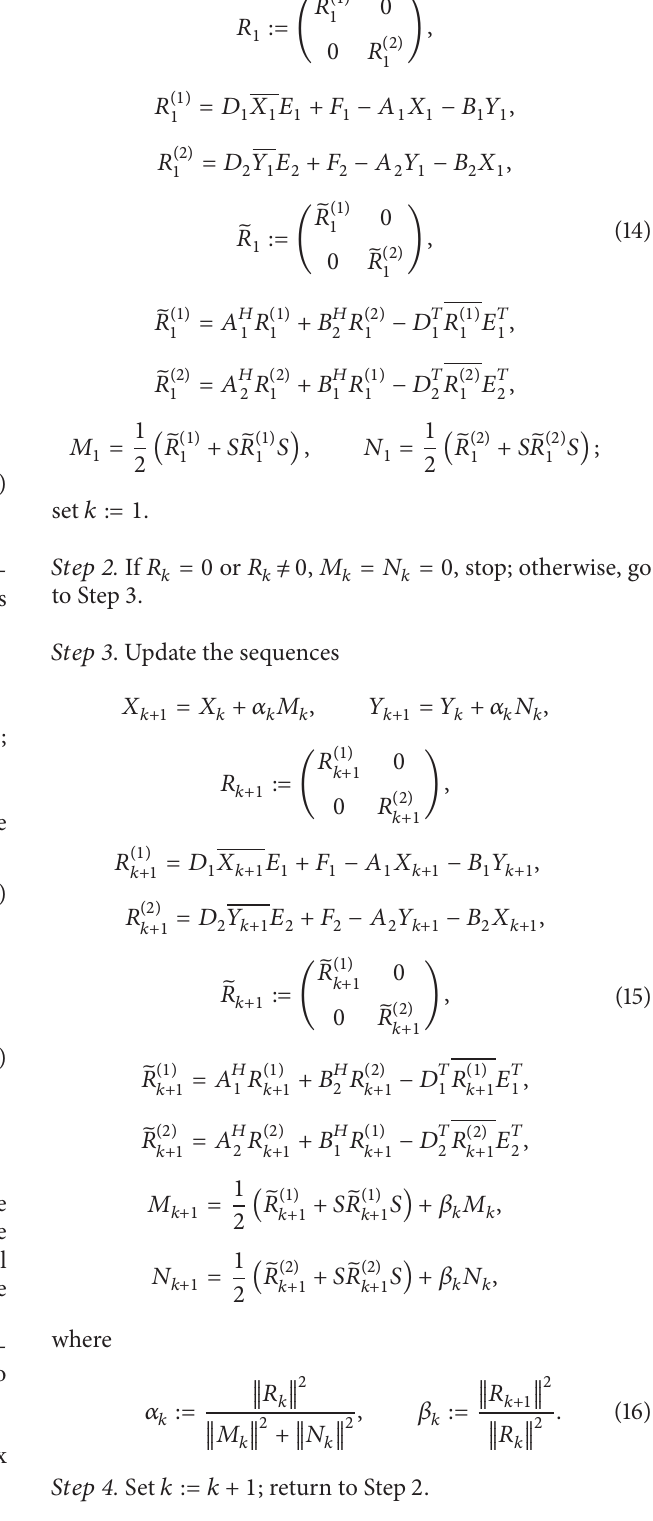
Algorithm 4 (MCG method for centrally